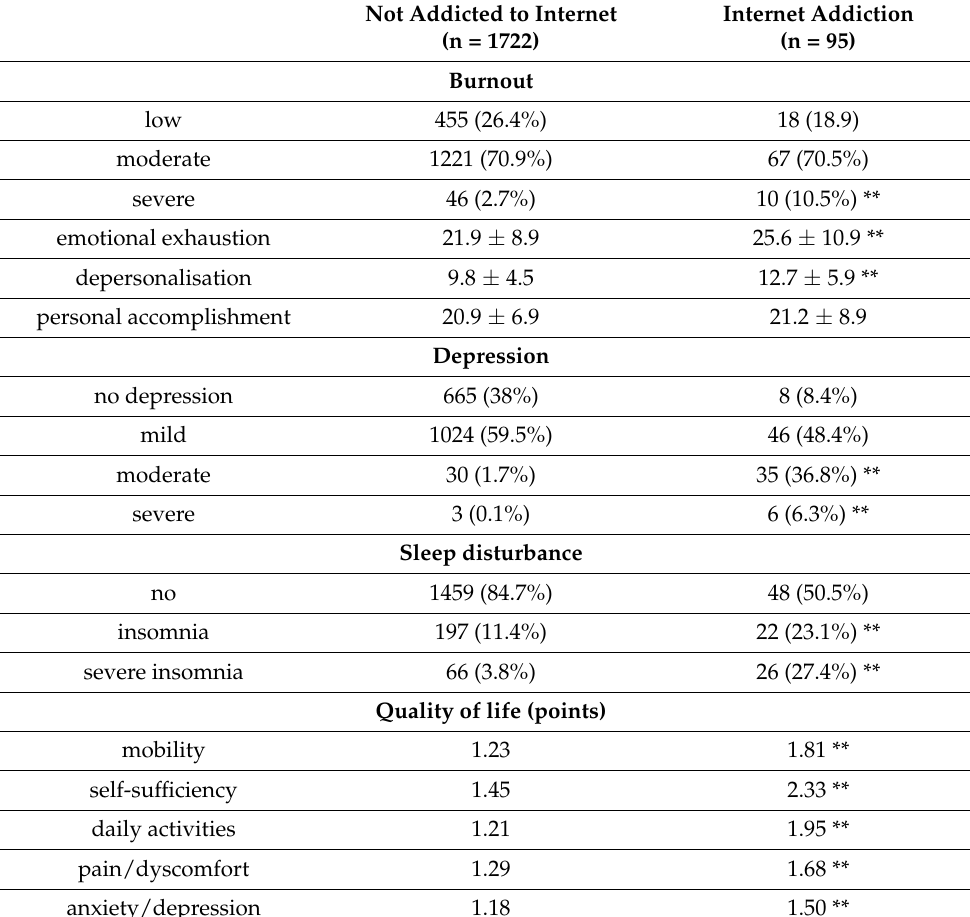
Table 1. Comparison of burnout, depression, sleep disturbance, and quality of life among the subgroups.